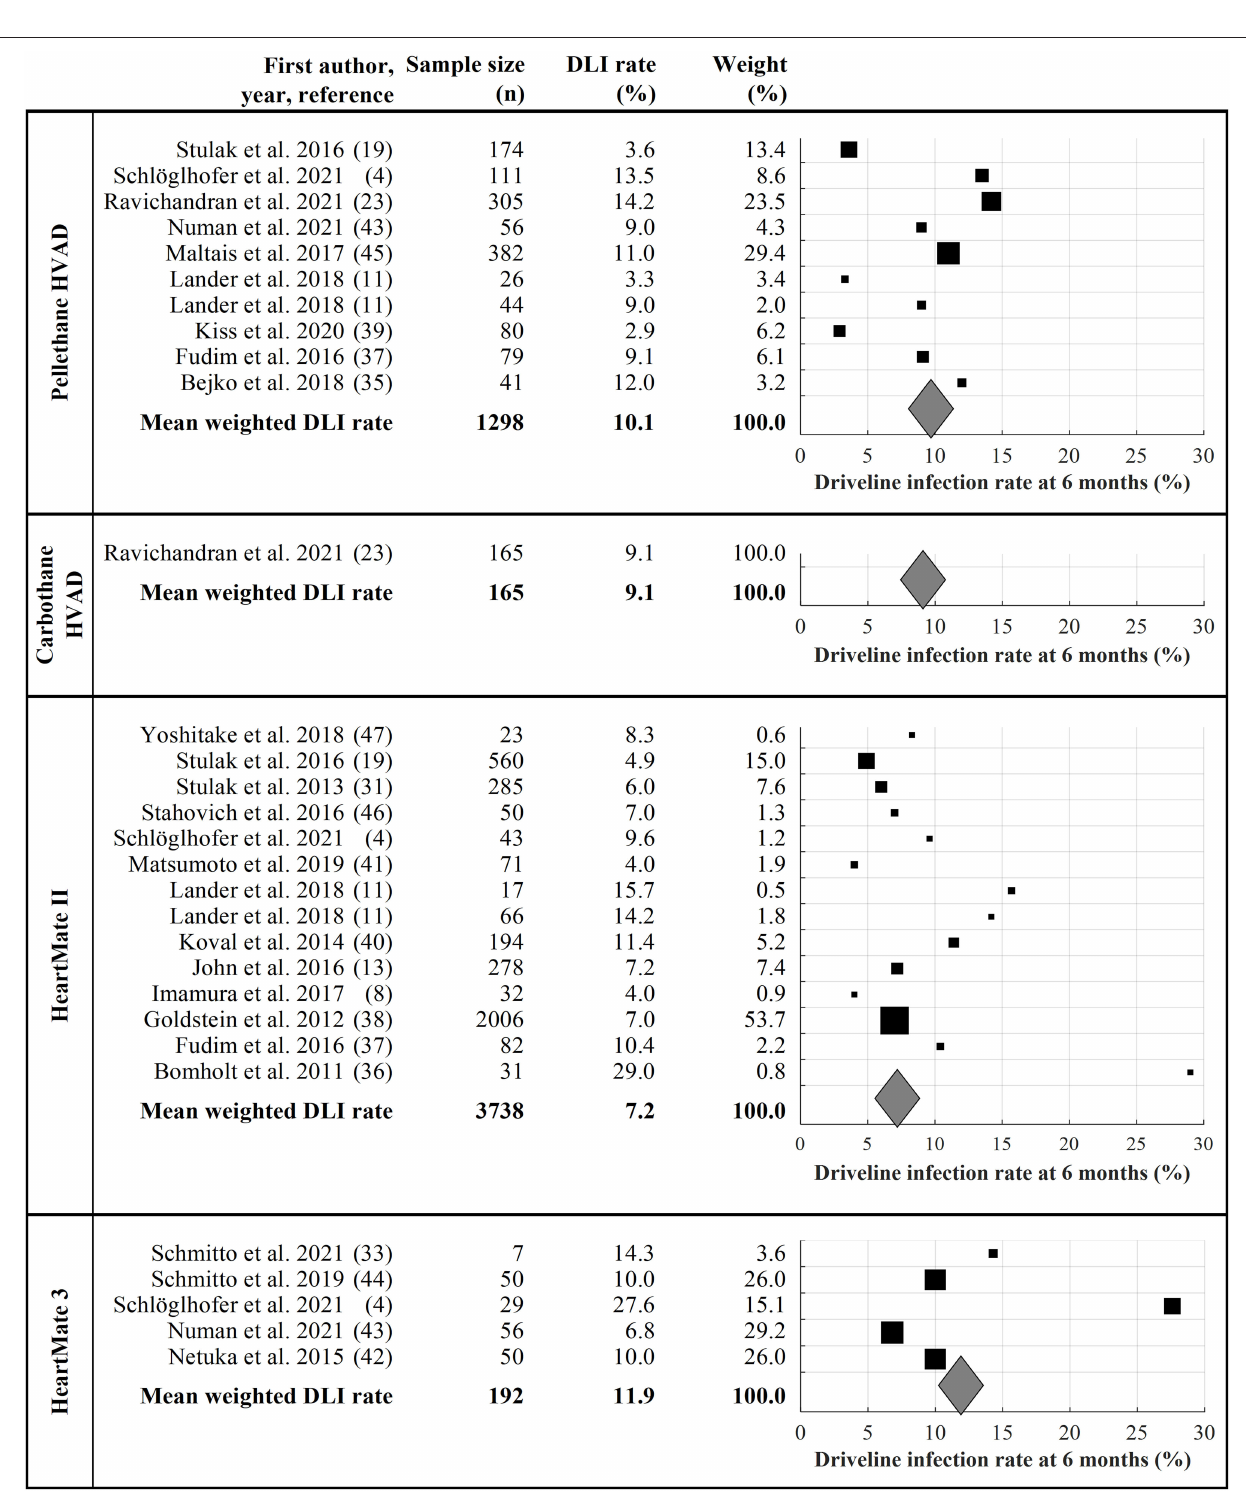
Frontiers in Cardiovascular Medicine |